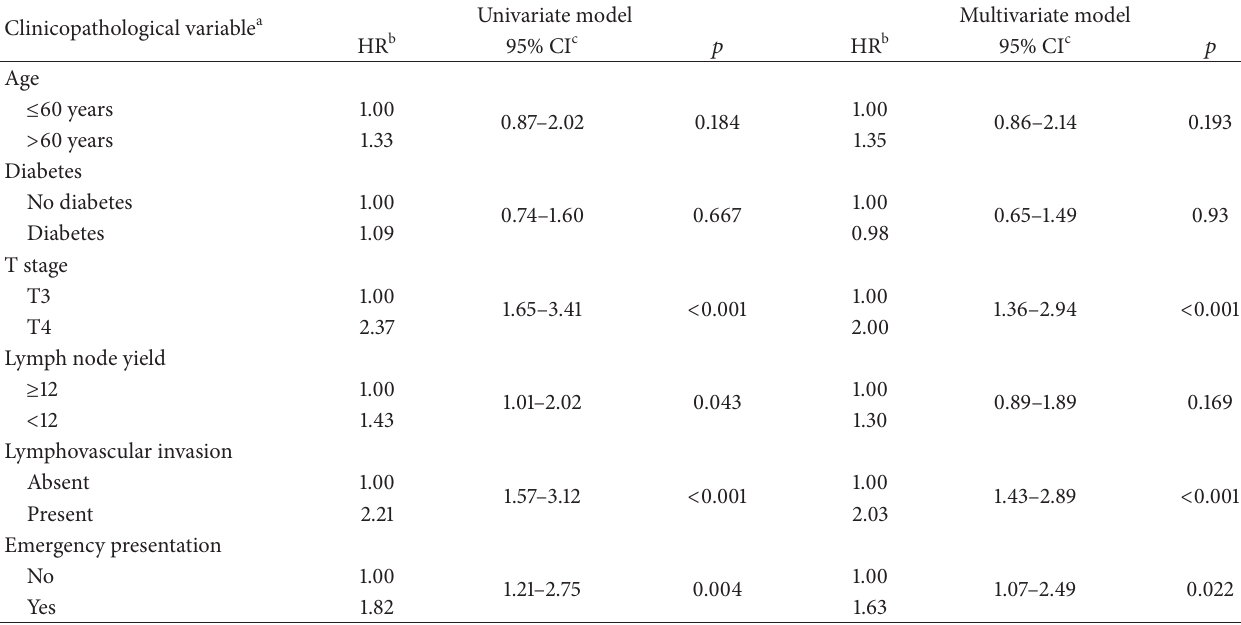
Table 4: Univariate and multivariate analyses for recurrence-free